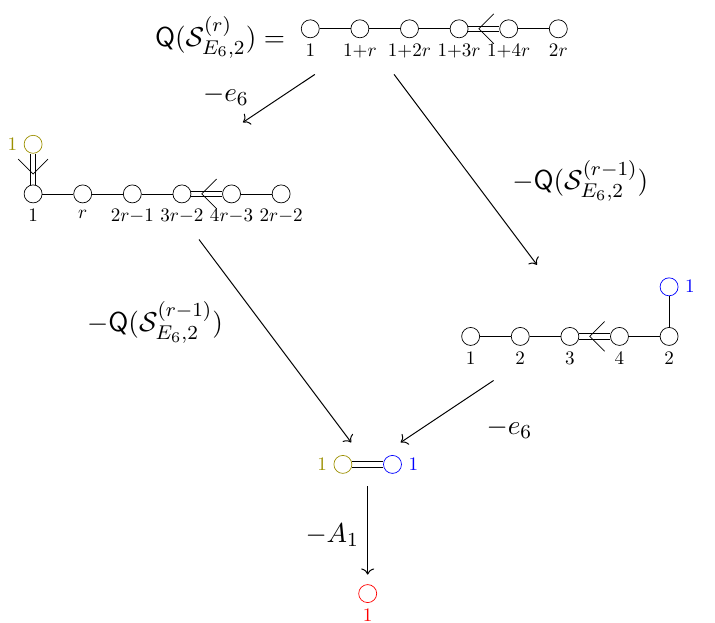
Figure 13. Demonstration of the emergence of an A 1 slice in the Higgs branch of S ( r ) subtraction on its magnetic quiver. Q ( S ( r − 1)